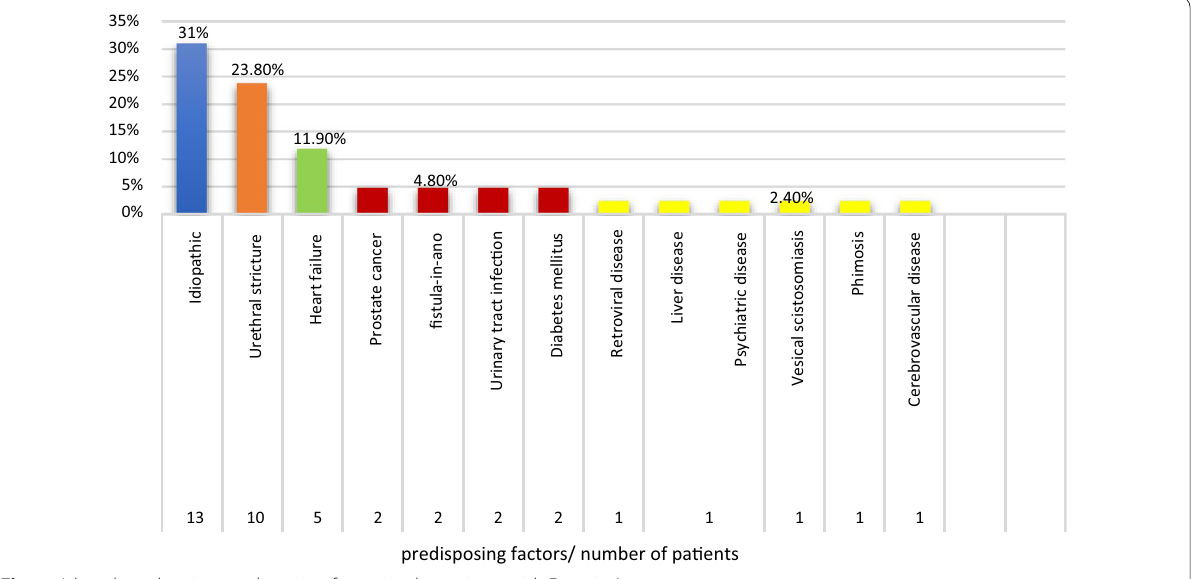
Fig. 1 A bar chart showing predisposing factors in the patients with Fournier’s gangrene